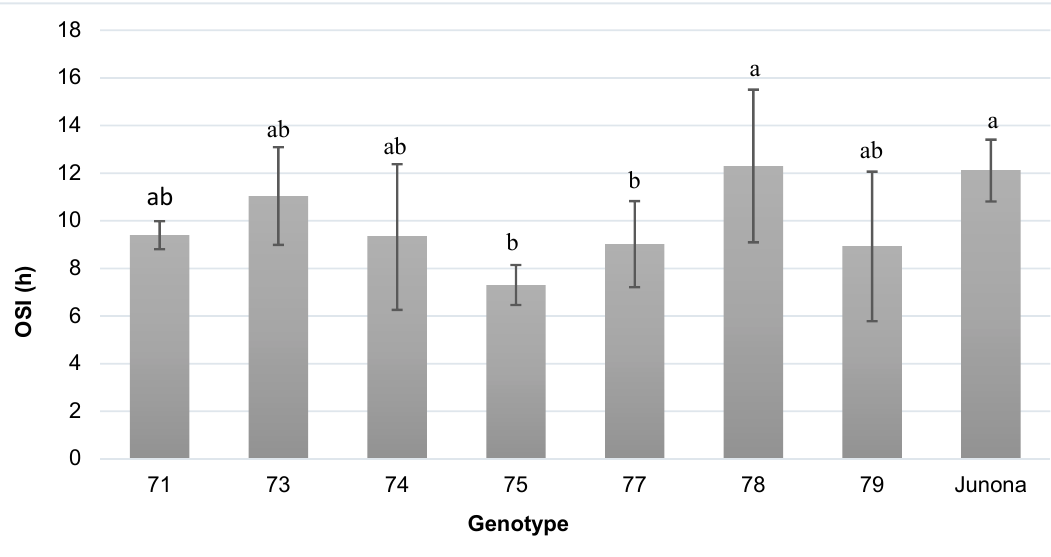
Figure 2. Oxidative stability index (OSI) determined for total lipids of studied Styrian oil pumpkin seeds (average value (calculated for two years) and standard deviation). a,b—average values with the same letter are not significantly different at p ≤ 0.05. Table 6. Pearson’s correlation coefficients between OSI values and selected pumpkin oil chemical compounds.